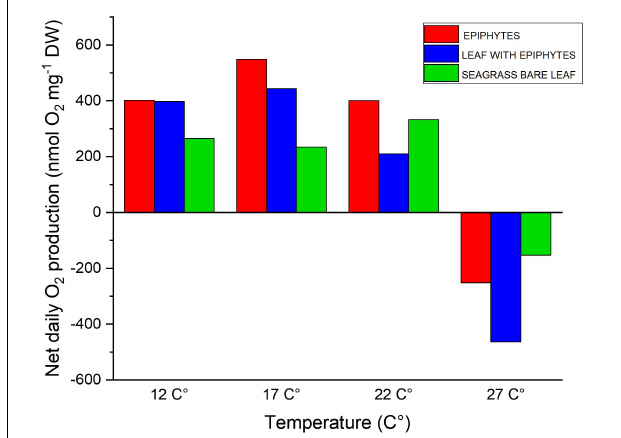
FIGURE 3 | Diel oxygen budget as function of increasing temperatures (12, 17, 22, and 27 ◦ C), illustrating the daily net oxygen surplus of the leaf and epiphyte communities. Red bars represent epiphytes originating from Z. marina leaves. Blue bars represent Z. marina leaves with epiphytes. Green bars represent bare Z. marina leaves. The daily net oxygen production was calculated from the fitted exponential saturation models at increasing temperature (see Figure 1 ; all with a R 2 ≥ 0.99) using an in situ measured 14h:10 h light/dark cycle (Staehr et al., 2018). The averaged exponential saturation fits were calculated from a biological replication of 4.